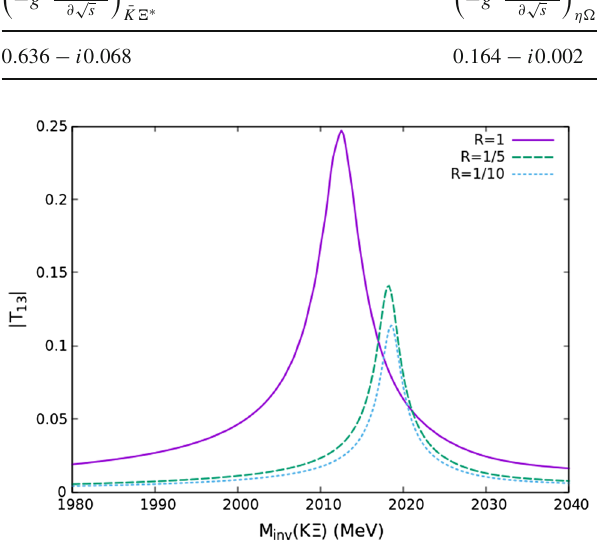
Fig. 8 Comparing | T 13 | using R α as a parameter, for different values of R